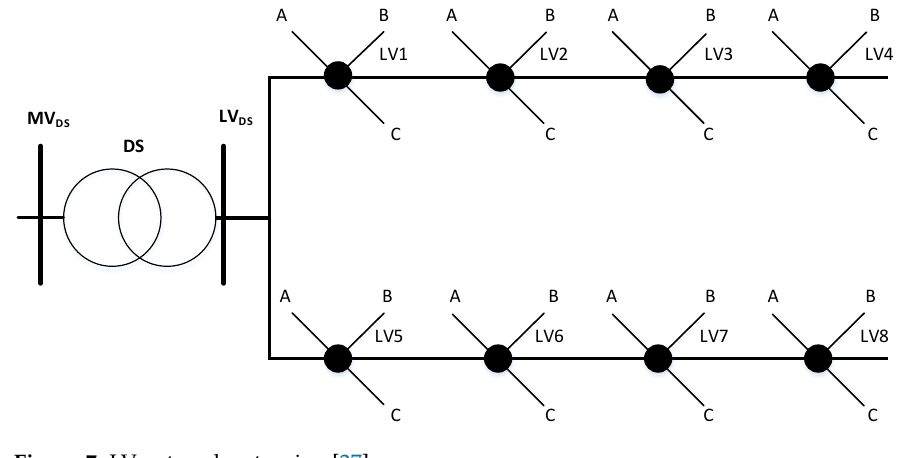
Figure 7. LV network extension